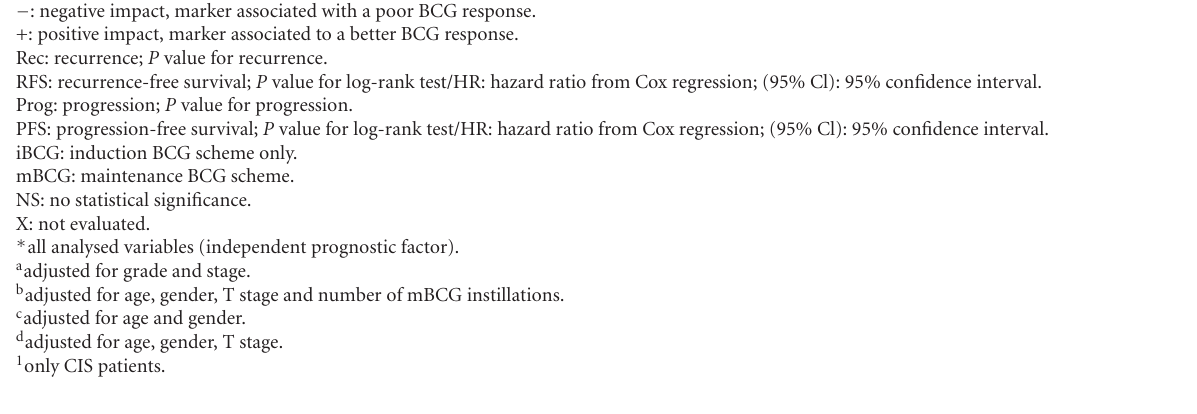
tion, used as a marker of cell proliferation index. Higher ki- 67 expression seems to be associated with recurrence after BCG [27, 31, 35, 37] and with lower time to recurrence